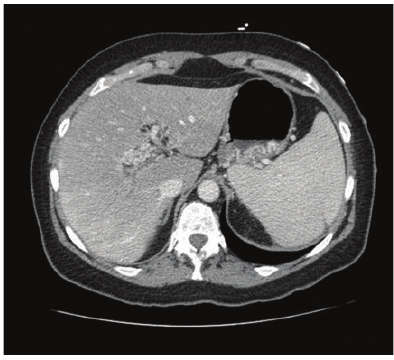
Figure 5: CT demonstrated periportal collateral circulation and gastric